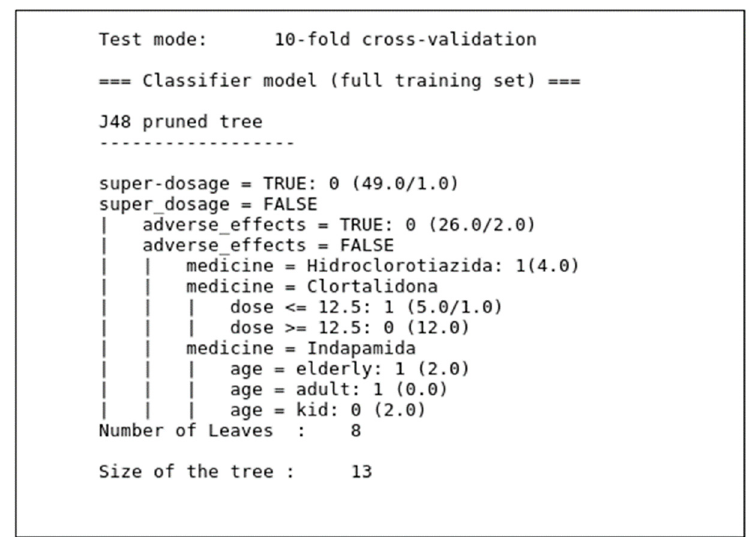
Figure 8. Decision tree from the J48 model.